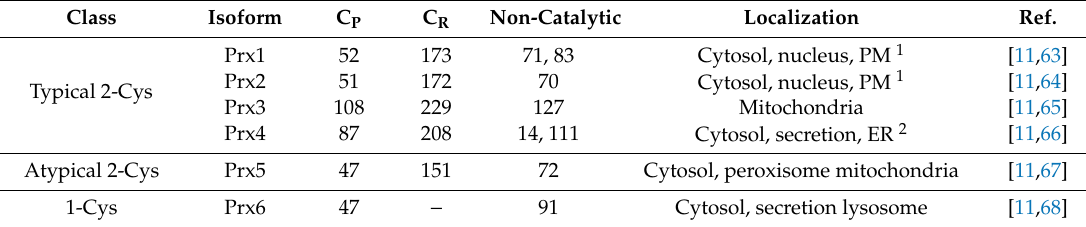
Table 2. Peroxiredoxin (Prx) isoforms in mammalian